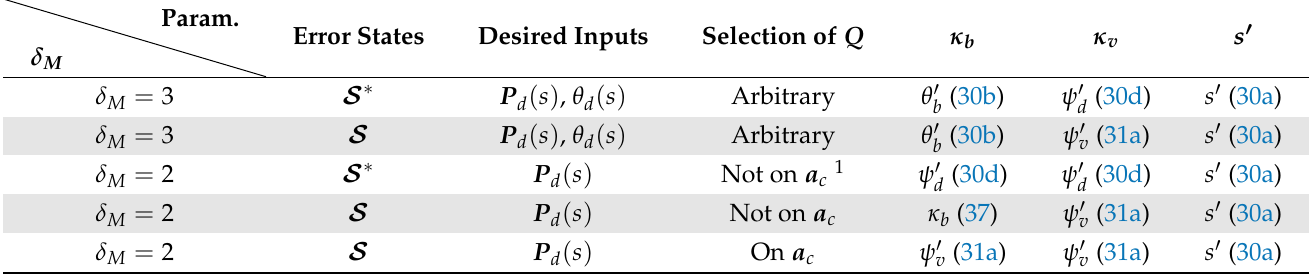
Table 3. Customization of the